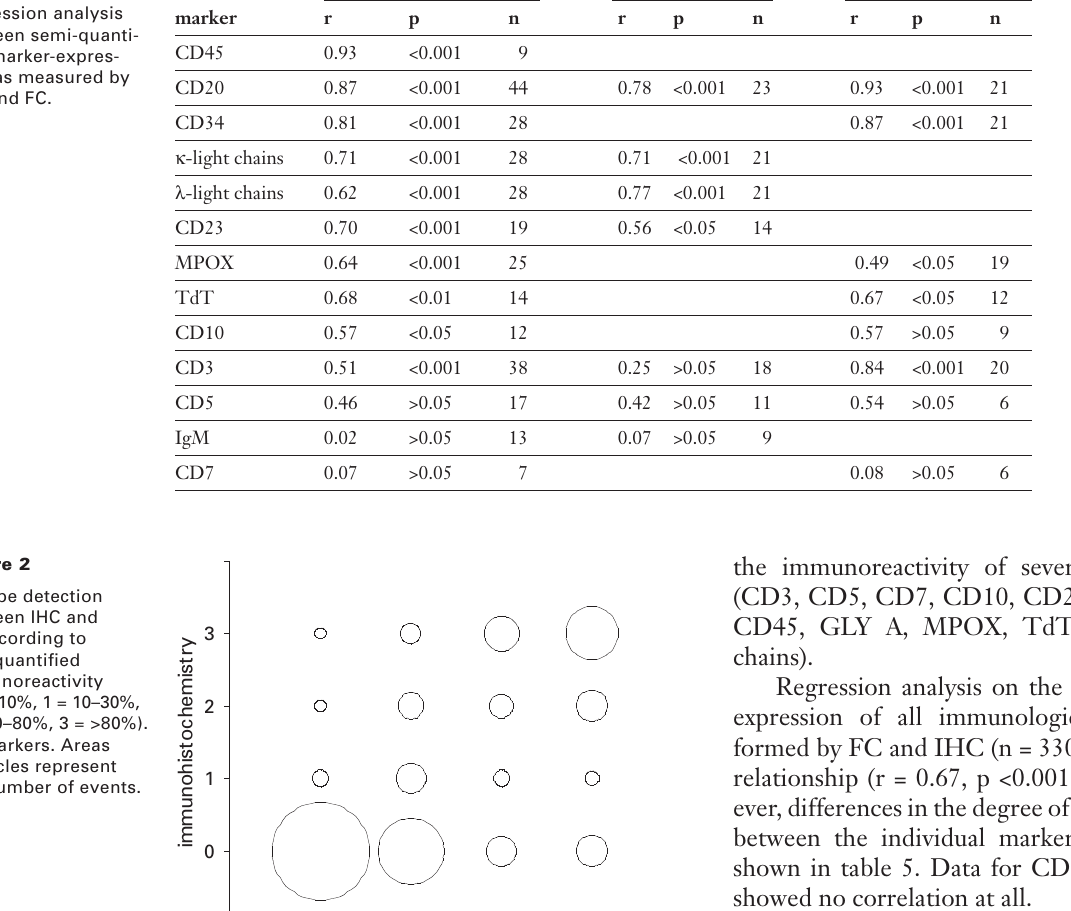
Differences of mea- sured expression between IHC and FC dependent on differ- ent antibodies used for FC.